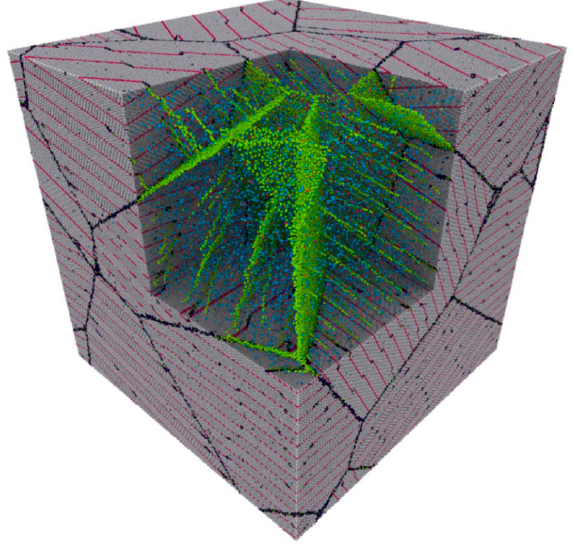
Figure 14. Simulated microstructure of Cu atoms doping Ag grain and twin boundaries; green represents Cu. Reproduced with permission from Reference [257]. Copyright 2019, Springer Na- ture.